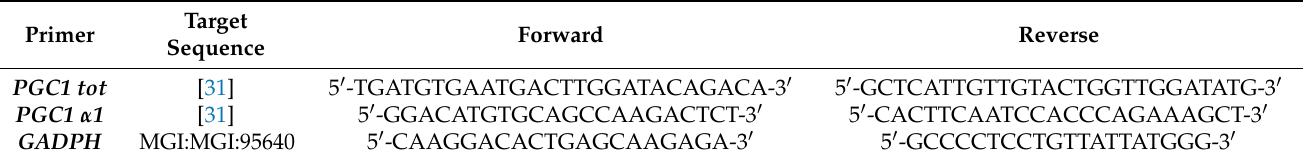
Table 1. Forward and reverse primers used for